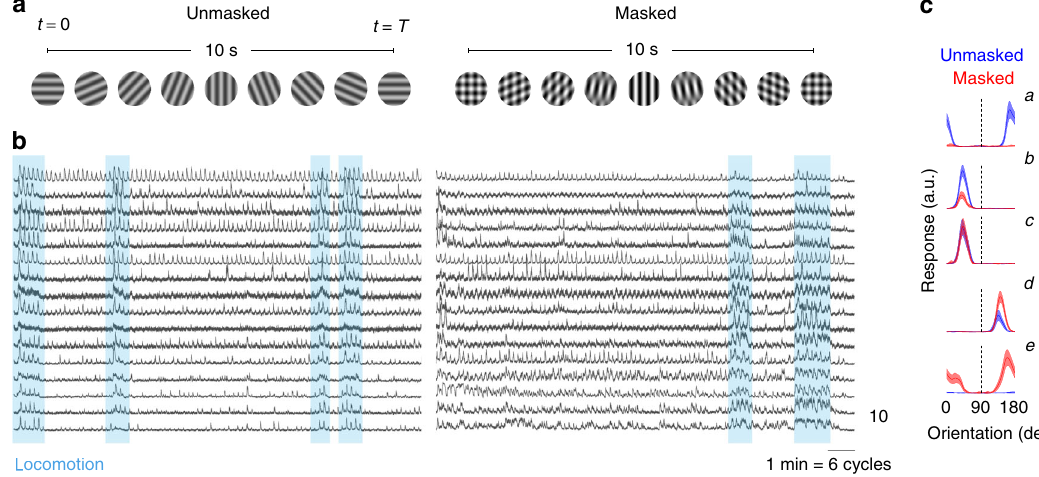
Fig. 1 Measurement of population responses in masked and unmasked conditions. a Structure of the visual stimulus. Each of the lines show a single period of the stimulus in unmasked and masked conditions. b Examples of responses by individual neurons in both conditions. Periods of locomotion enhanced the overall responsivity of the population (shaded regions). Traces are plotted on a z-scored scale (vertical bar = 10). Horizontal bar represents 1 min of stimulation (or six periods of the orientation cycle). c Tuning in unmasked and masked conditions. Each trace shows the response of a neuron over the stimulation cycle after correction for neural delay, so they can be interpreted as a sweep of the orientation tuning curve of the neuron. The dashed line indicates the orientation of the mask. Blue traces represent the responses in the unmasked condition, while red traces represent responses in the masked condition. Shaded areas represent the mean response ± 2 SEM